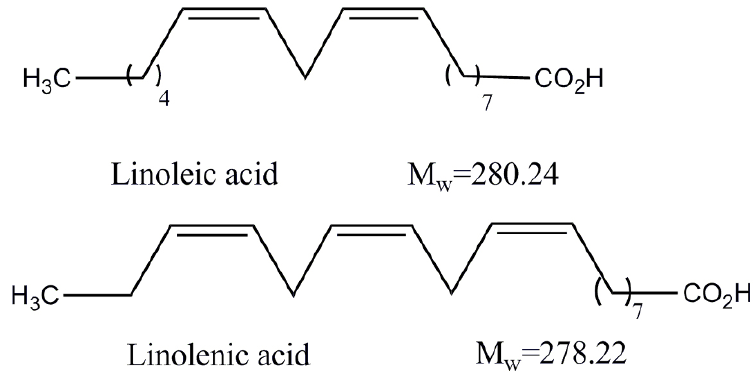
Figure 1. Fatty acid chemical structures (CLA